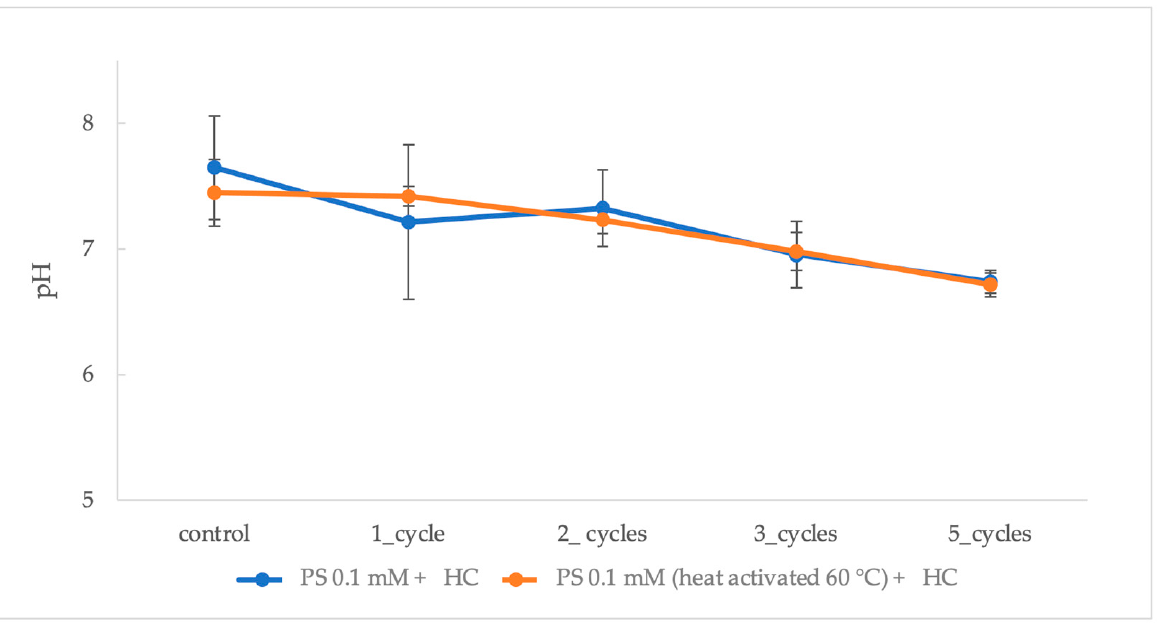
Figure 6. The pH levels of samples after treatment with PS (0.1 mM) activated by HC; 1, 2, 3, and 5 cycles through the unit corresponding with 4, 8, 12, and 20 s of treatment, and after treatment with PS (0.1 mM) activated by HC combined with heat (60 °C); 1, 2, 3, and 5 cycles through the unit corresponding with 4, 8, 12, and 20 s of treatment .